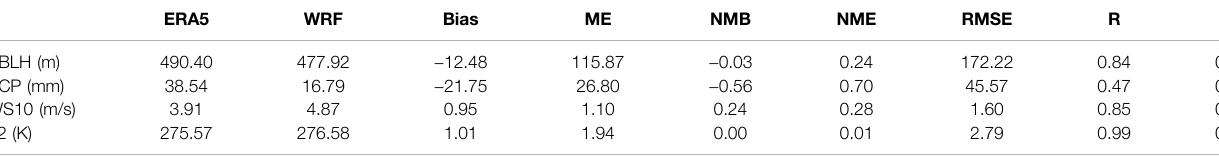
TABLE 2 | Statistical parameters for simulated meteorology at all grid cells within the model